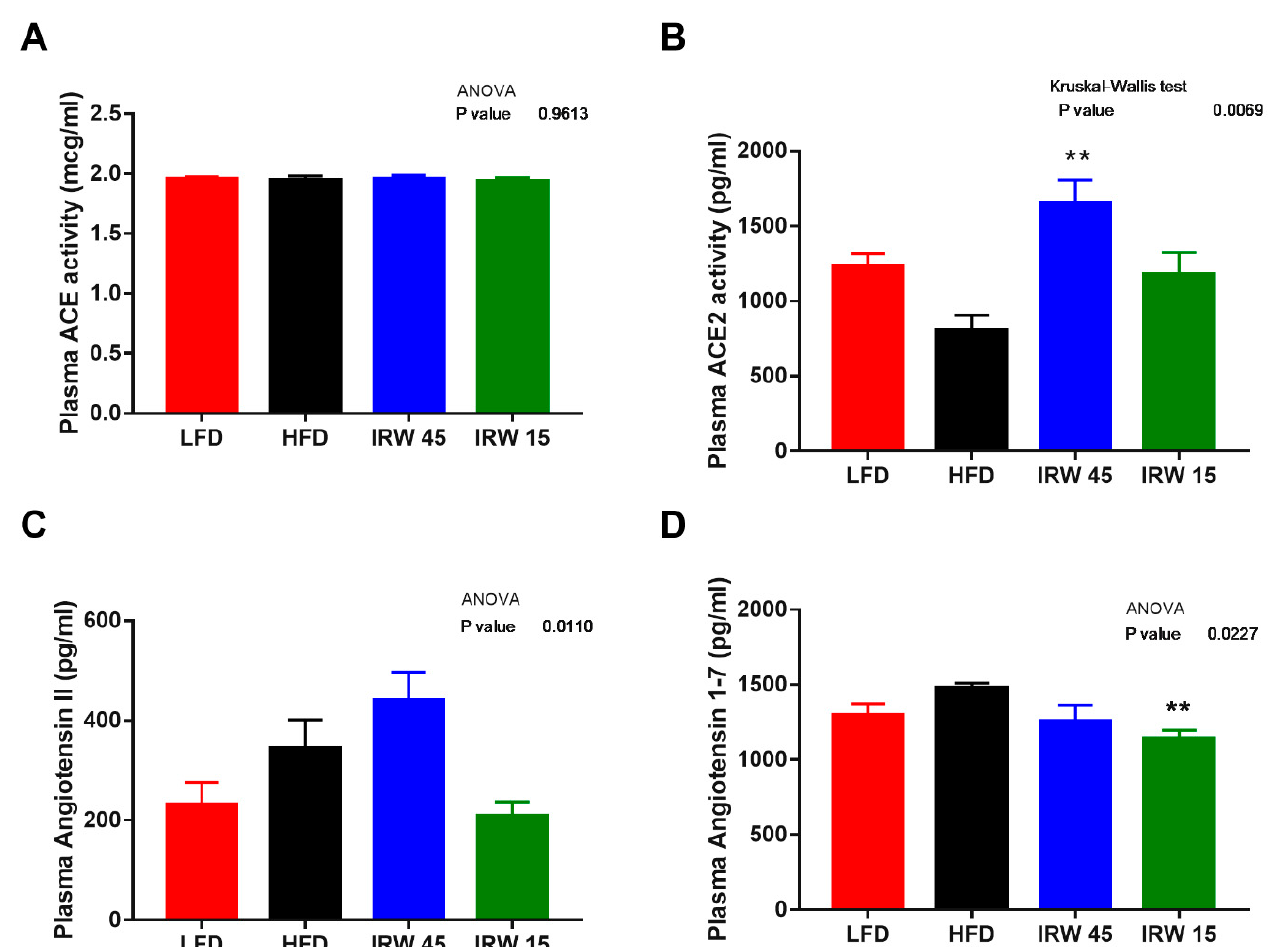
Figure 4. Plasma renin angiotensin system components. ( A ) Plasma angiotensin converting enzyme (ACE), ( B ) Plasma angiotensin converting enzyme 2 (ACE2), ( C ) Plasma angiotensin II, and ( D ) Plasma angiotensin (1–7). Data expressed as mean ± SEM of n = 4–7 mice. Analysis by one-way